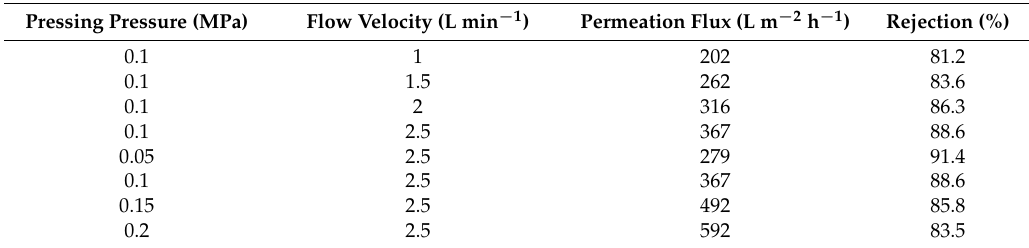
Table 2. Stable permeation flux and rejection (%) of oil from the membrane S1350-1650 at various pressing pressures and flow velocities (it corresponds to Figure